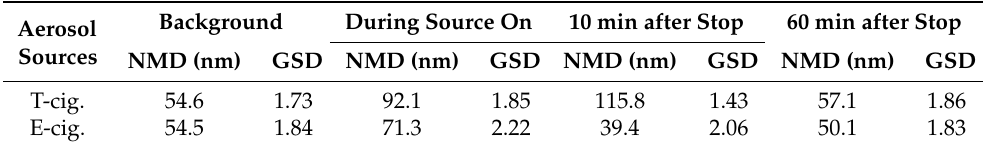
Figure 7. Surface area for six indoor aerosol sources (candles, cooking, electronic cigarettes, tobacco cigarettes, mosquito coils and incense) at different times (before being turned on, during operation and after being stopped). Table 2. Number size distribution parameters of ultrafine particles for different aerosol sources, Adapted from